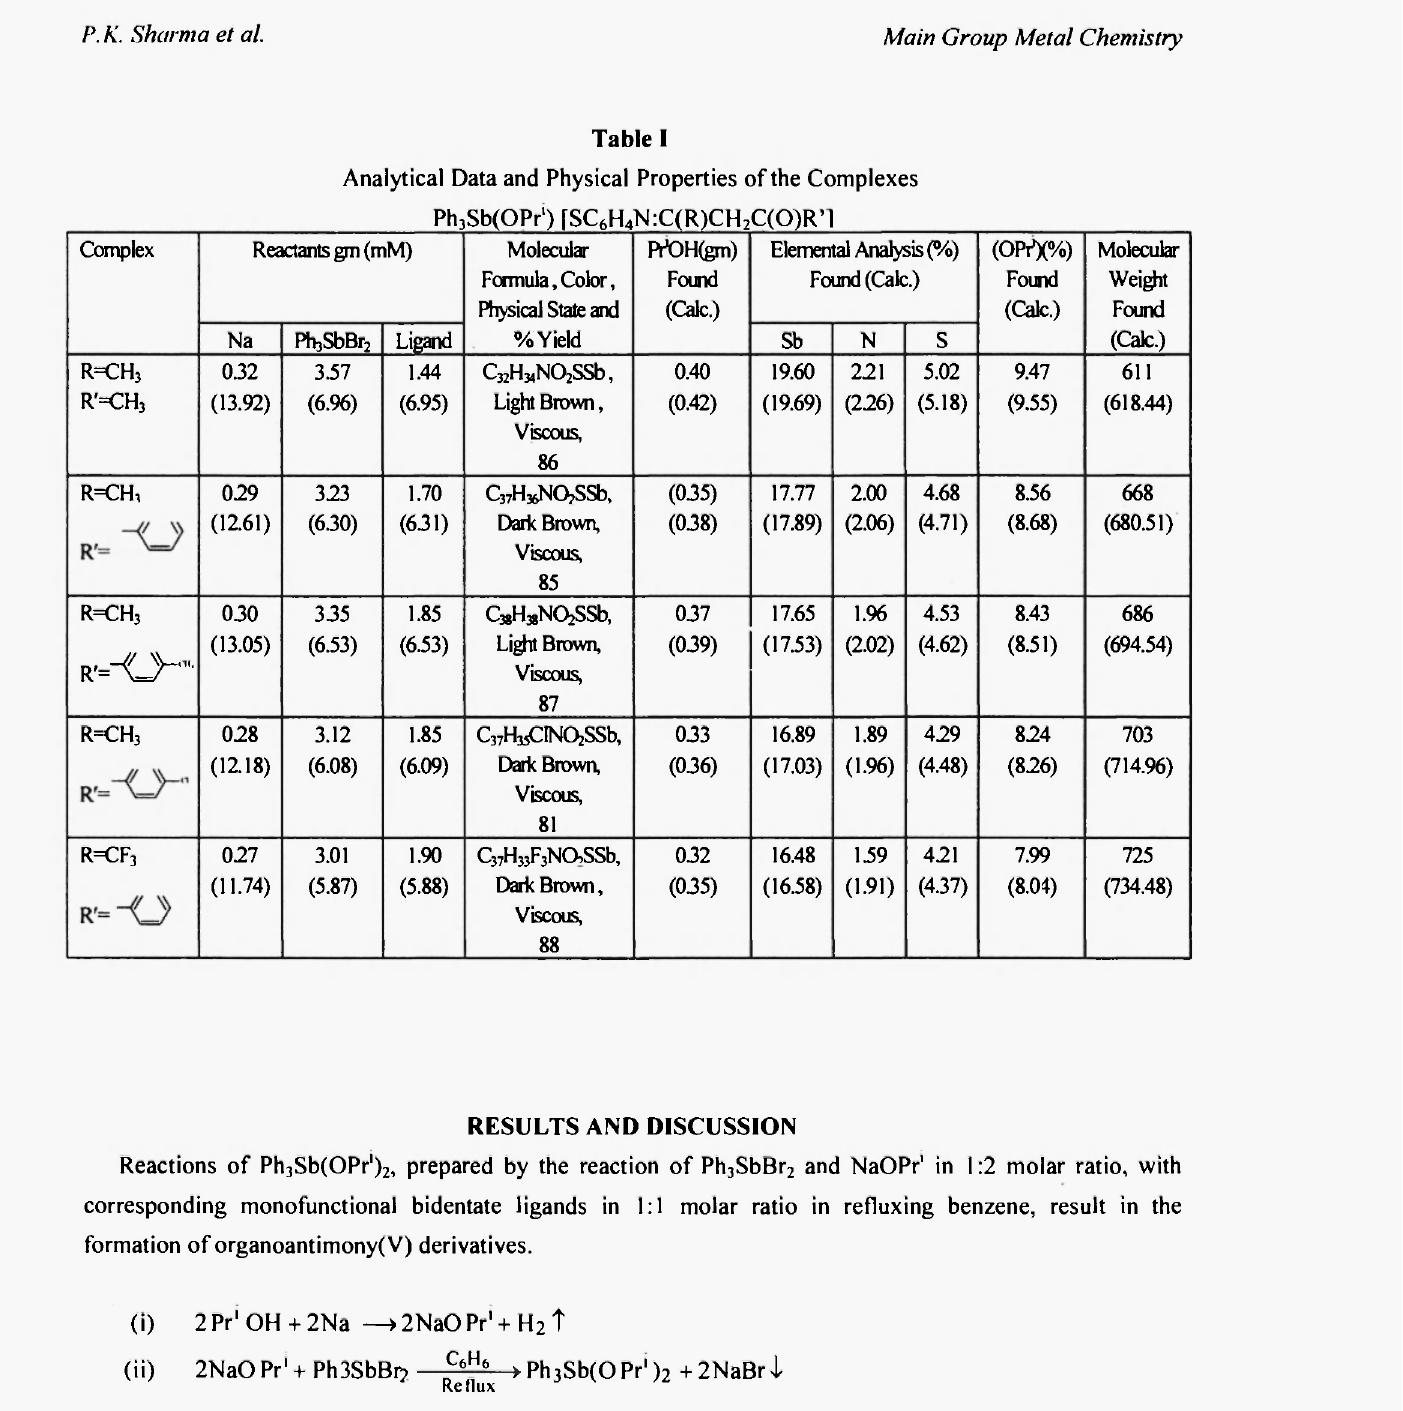
Analytical Data and Physical Properties of the